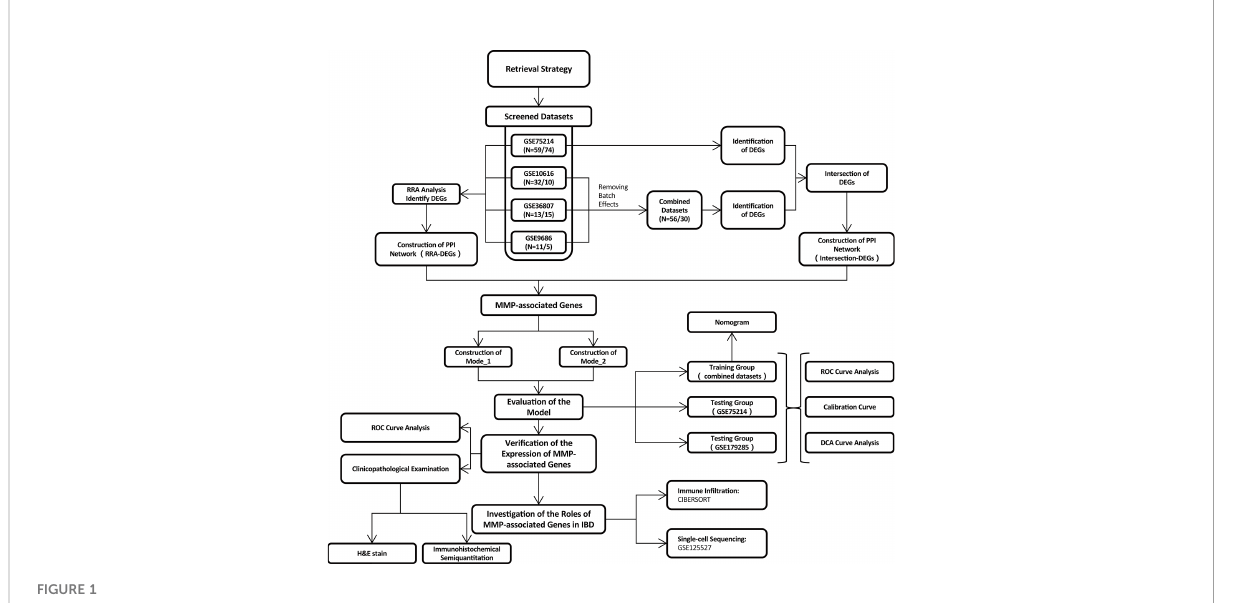
FIGURE 1 Flowchart of the overall study